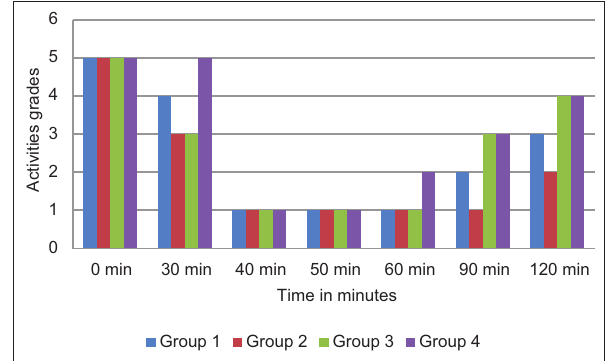
Figure-1: Sedative-hypnotic activities of the methanol leaf extract of Ficus exasperata in mice.